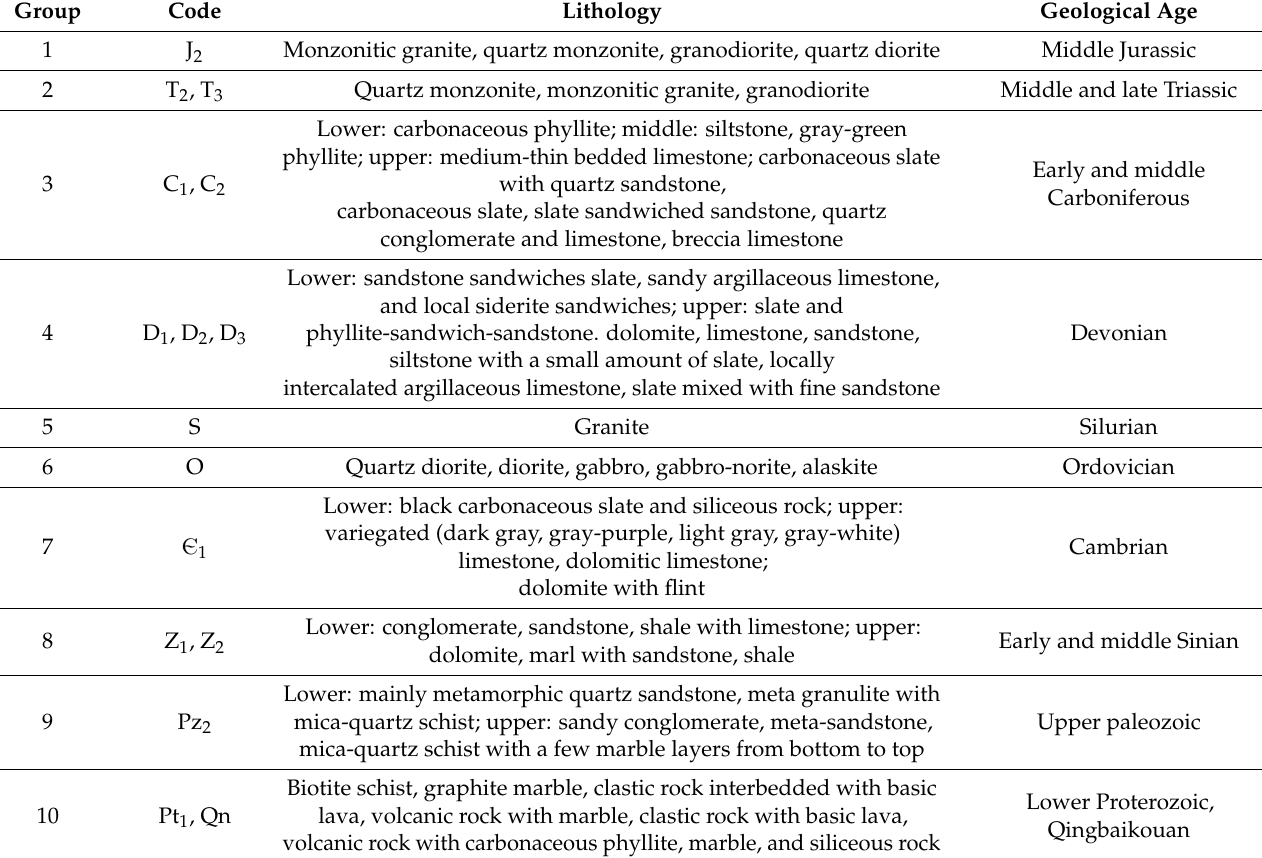
Table 1. Description of the groups of lithologies.